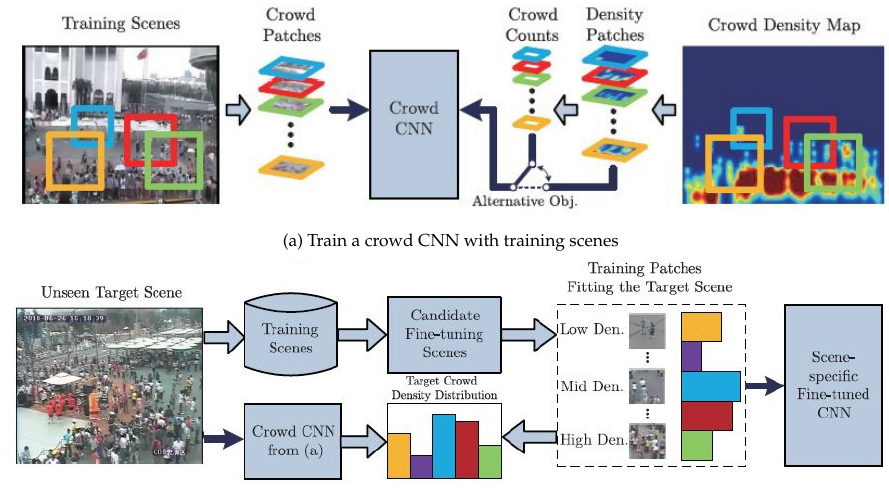
Figure 4. The internal structure of the cross-scene network with a fine-tuning scene module to generalize for unseen data. Image from